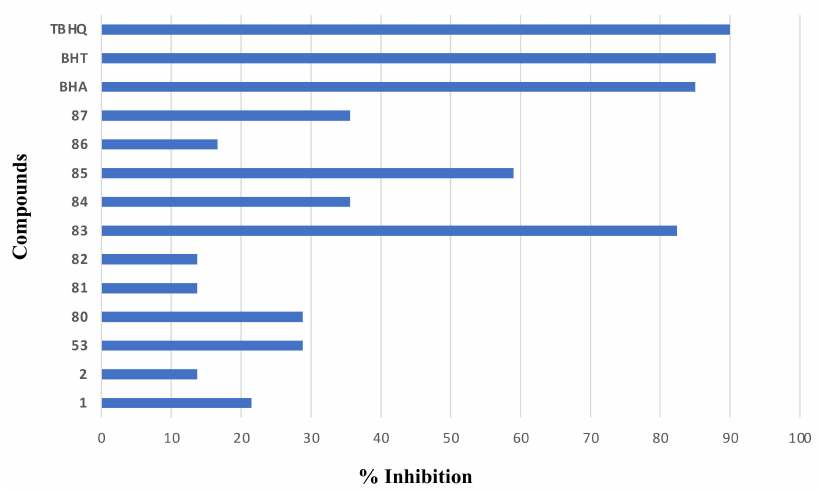
Figure 17. Lipid peroxidation inhibitory activity of (+)-stemodin ( 1 ) analogues and positive controls, BHA, BHT and TBHQ. Compounds were tested at 25 µ g/mL. Positive controls were tested at 10 µ M [83].